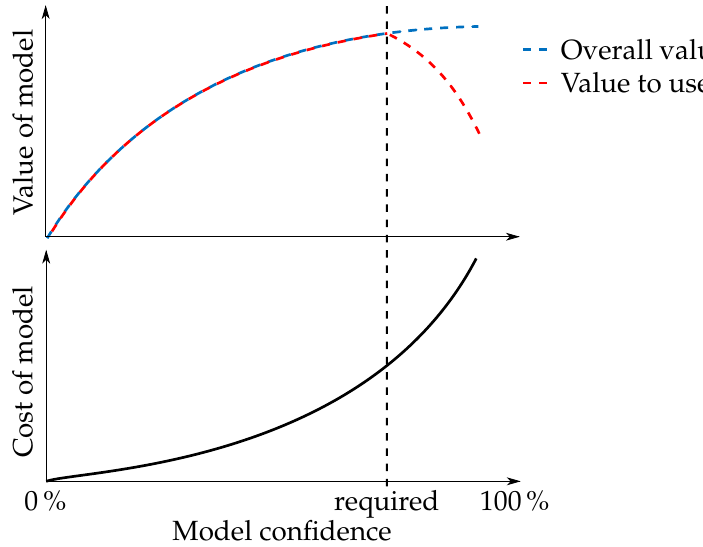
Figure 3. Illustration of relationship between value / cost of the model and its confidence.